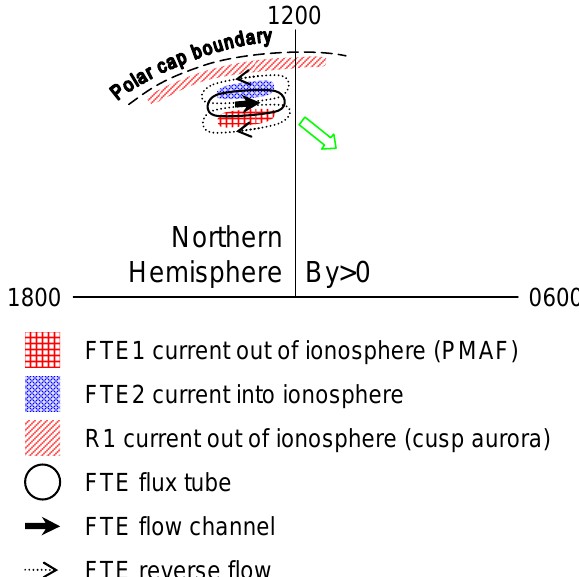
Fig. 9. Sketch showing the location of the FTE currents (former region 0) and the post-noon region 1 current relative to the polar cap boundary and the aurora for the Northern Hemisphere IMF B y > 0 and B z < 0 case studied in this paper. The perimeter of the FTE flux tube is encircled with a solid line, and the FTE current system is moving westward and poleward with the background convection, as indicated with the green